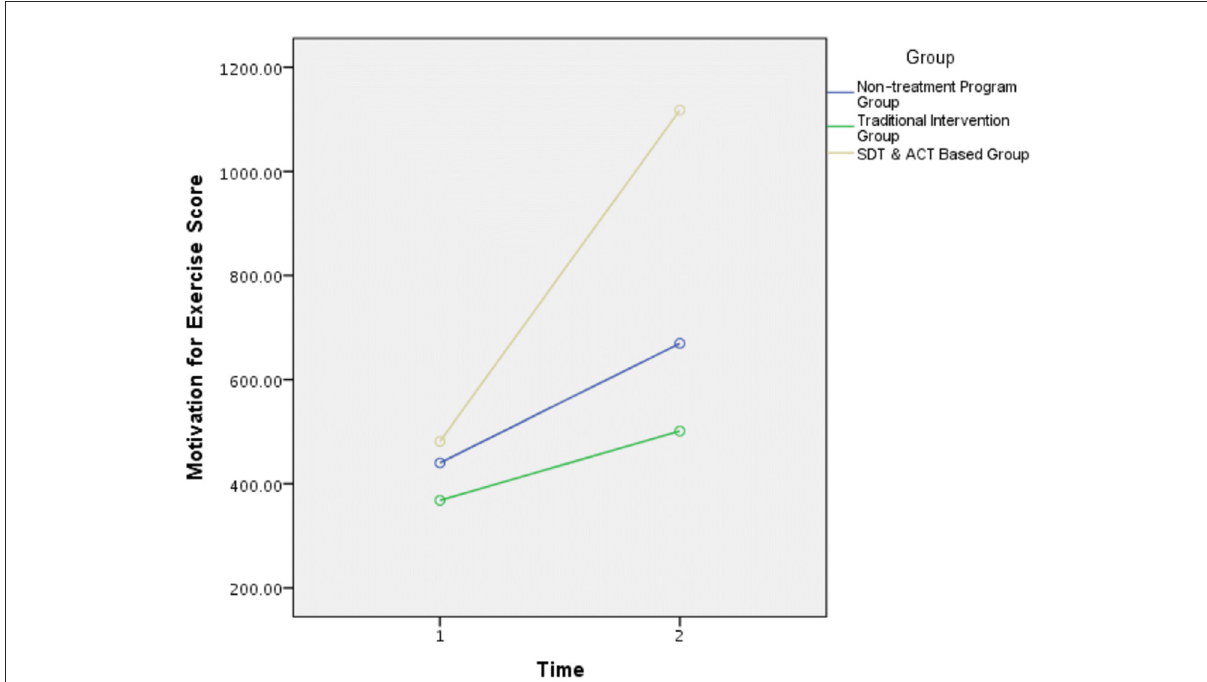
FIGURE2 Motivation for exercise score. All groups presented the same level of motivation for exercise score before the intervention (i.e., time 1). Following the intervention (i.e., time 2), SDT and ACT-based intervention group displayed a significant increase in motivation for exercise. Nonetheless, the two control groups (traditional intervention group and non-treatment group) did not show significant differences between the two-time measurements.